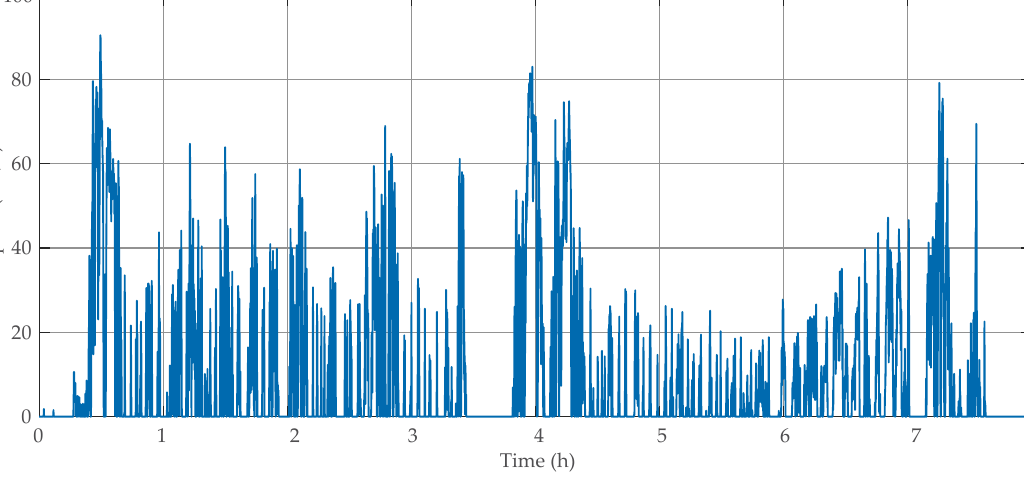
Figure 6. Real RCV drive